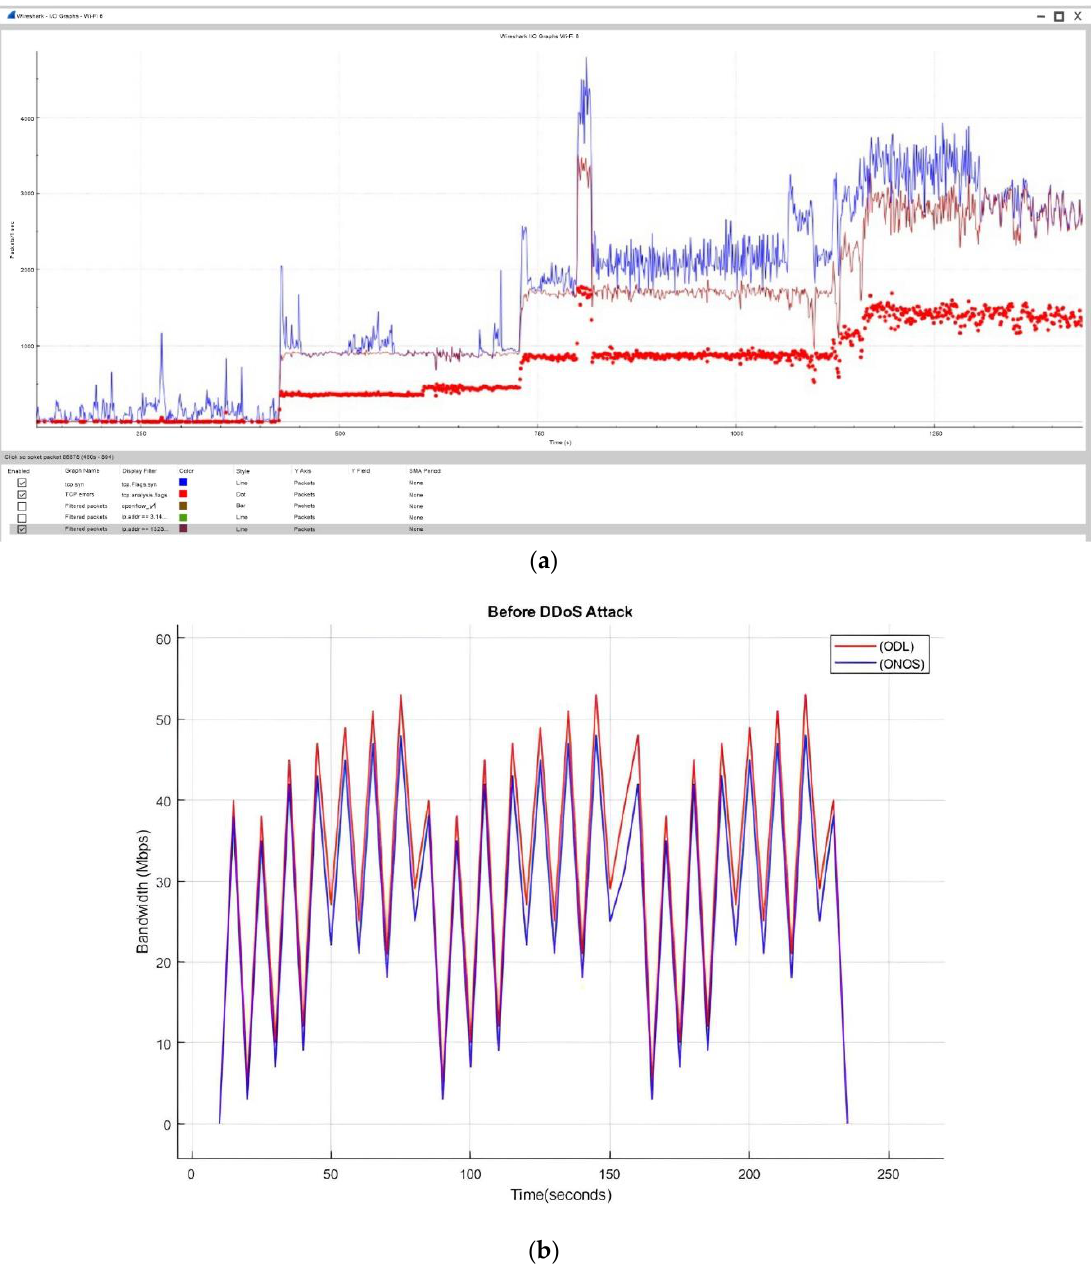
Figure 2. ( a ) Experimental Analysis Scenario before the occurrence of DDoS attacks; ( b ) difference in flow of network traffic once DDoS attacks is launched.